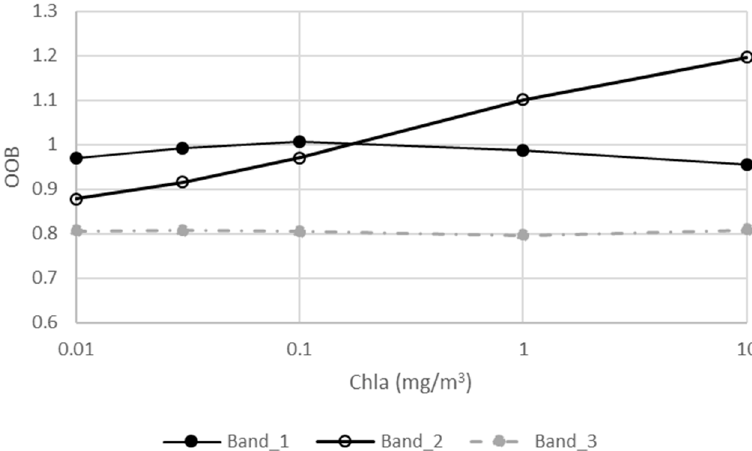
Figure 5. OOB correction factors for the three CZI visible bands in Case 1 water with chlorophyll a concentrations from 0.01 mg/m 3 to 10 mg/m 3 . The two CZI cameras had almost the same correction factors (relative difference <2.8%), so results from only one camera is shown here.